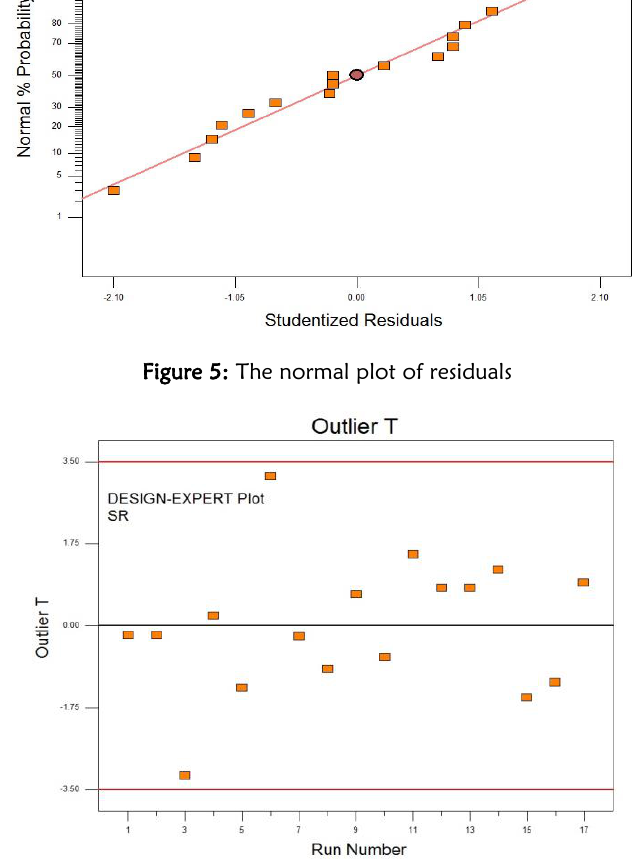
Figure 6: The outlier plot indicating the trial runs are within